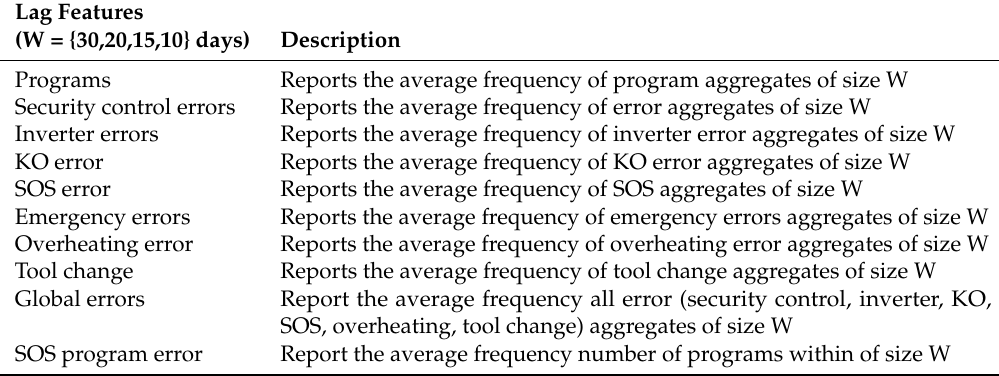
Table 1. Lagged feature variables obtained with feature engineering. KO: unexpected stop error, SOS: errors that contain the word